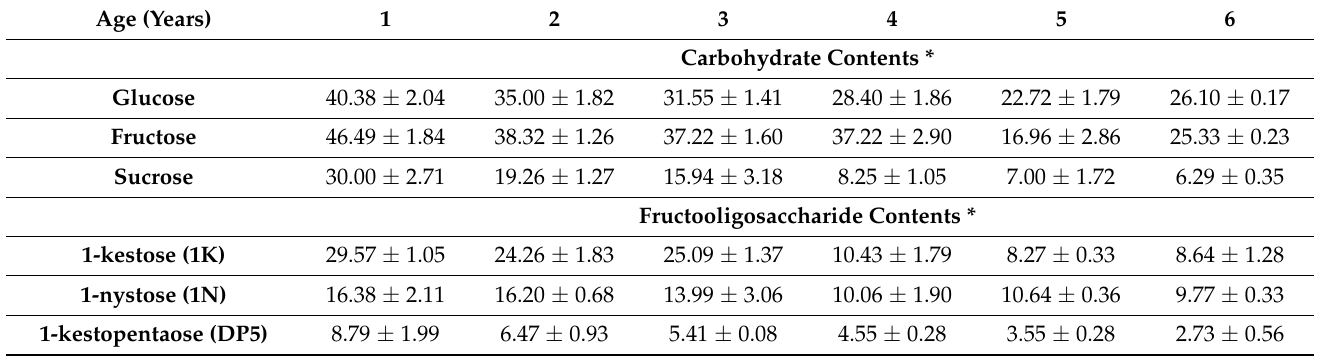
Table 3. Carbohydrate and fructooligosaccharide contents of A. potatorum Zucc. plants at different